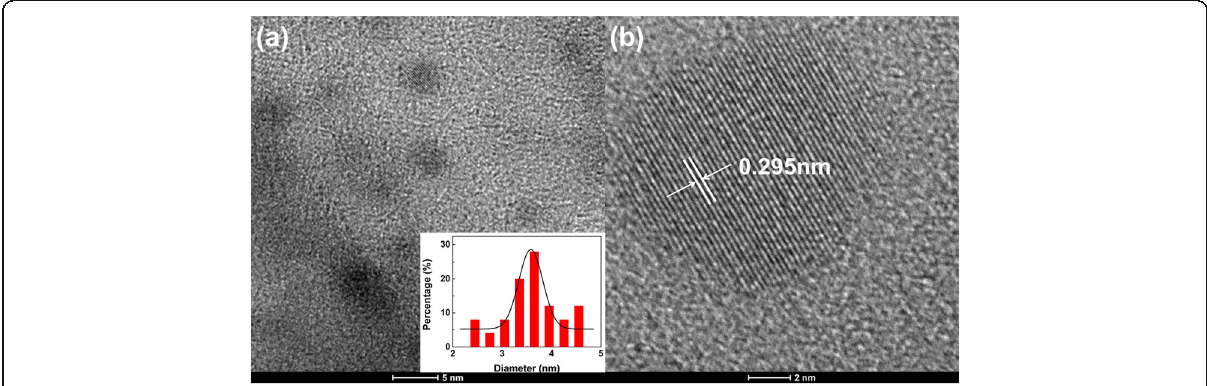
Fig. 1 TEM and HRTEM images of as-prepared CDs. a The transmission electron microscopy (TEM) image of as-prepared CDs ( insets showing particle-size distribution). b The high-resolution TEM image of one representative CD, which shows its crystallized graphite inner